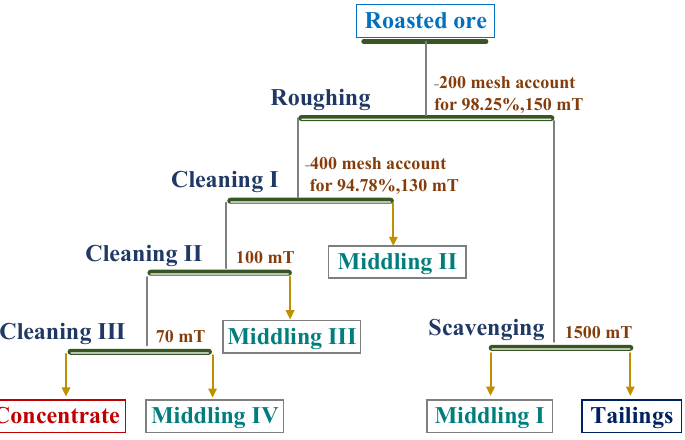
Figure 3. Flow chart of the magnetic separation process.